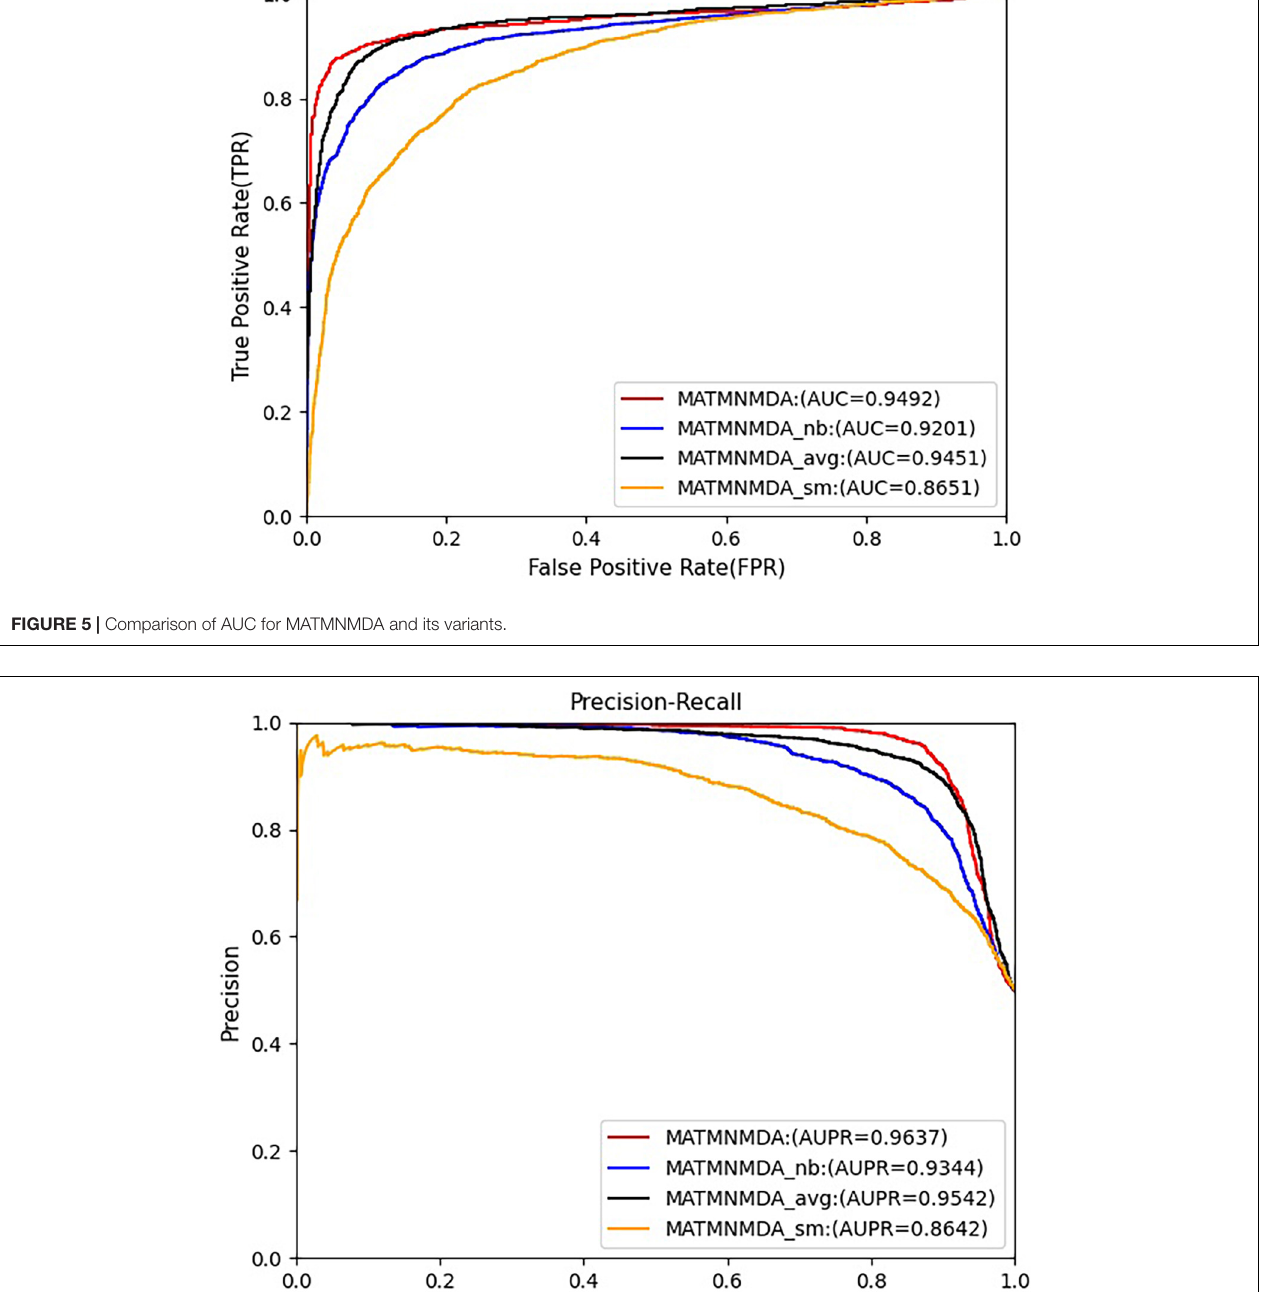
evaluation metrics, and its AUC and AUPR reach 0.9492 and 0.9637, respectively, which are better than all baseline